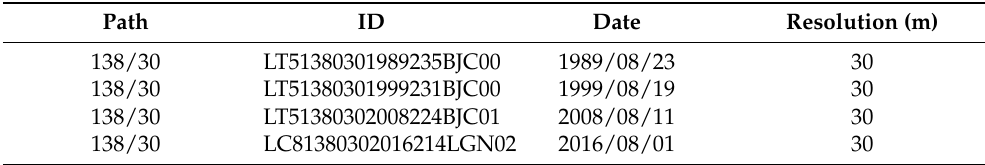
Table 1. Remote sensing data used in this